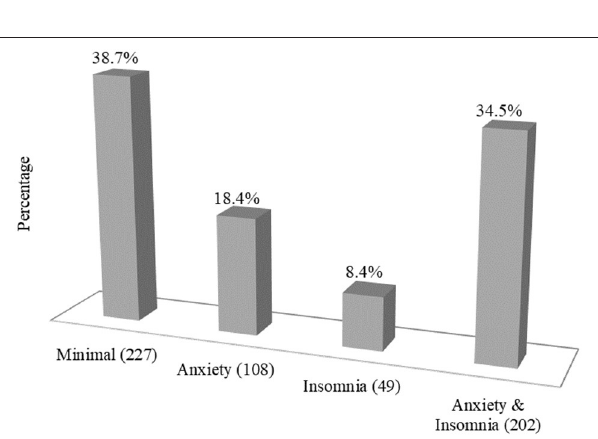
FIGURE 1 | Estimation of anxiety and insomnia among the urban slum residents.